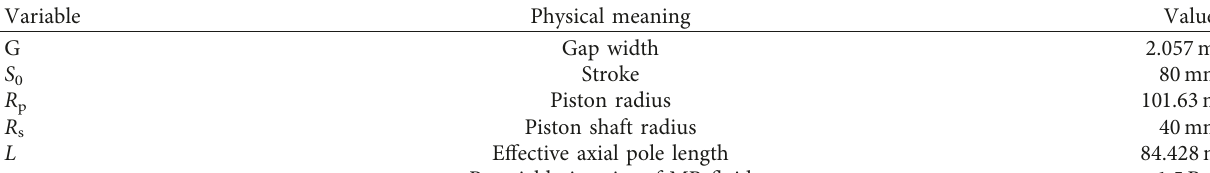
Table 2: The configuration of the damper in Yang’ study [34].